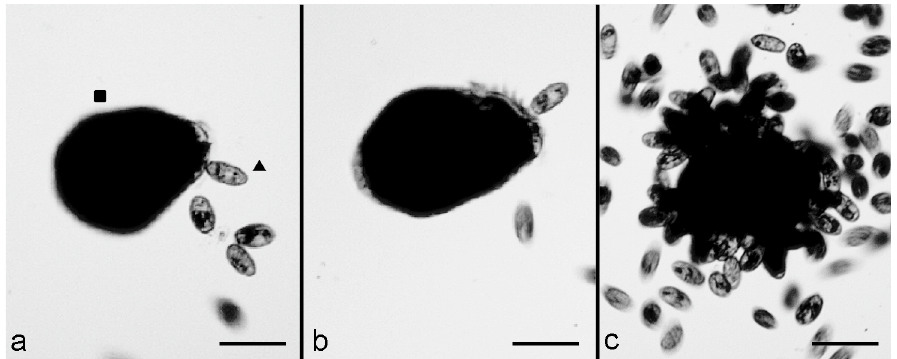
Figure 2. The predatory behaviour of C. hirtus ( (cid:78) ) on an extrusome-deficient cell of S. polymorphus ( (cid:4) ). ( a ) A cell of C. hirtus has an effective contact with an extrusome-deficient cell of S. polymorphus with its anterior portion, and the prey immediately contracts. ( b ) The predator remains attached to the prey while other cells of C. hirtus contact the same prey. ( c ) the extrusome-deficient cell of S. polymorphus is fragmented and eaten by the predators. Photomicrographs obtained from a film clip. Scale bar = 100 µ